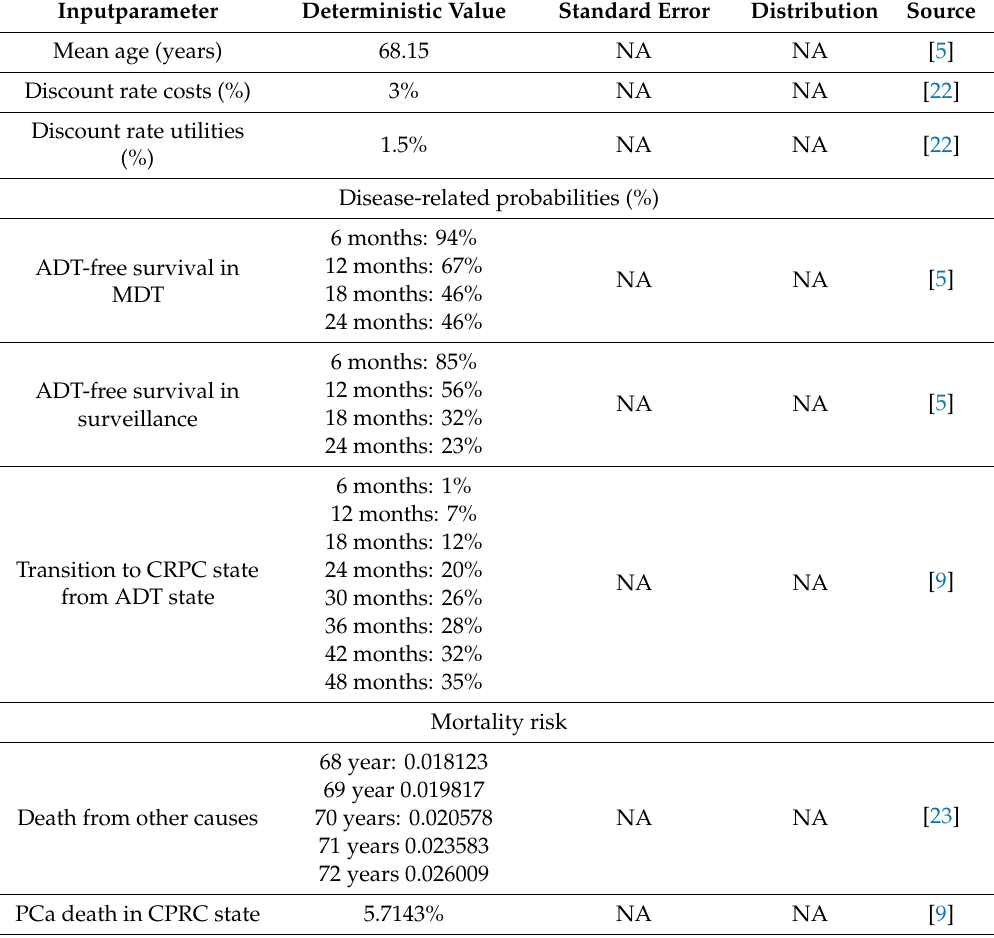
Table A1. General overview of the model input